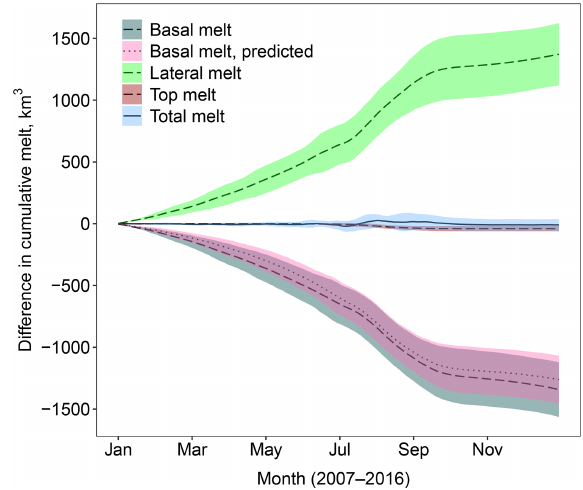
Figure 4. Difference in the cumulative lateral (green ribbon, dashed), basal (grey ribbon, dashed), top (red ribbon, dashed), and total (blue ribbon, solid) melts averaged over 2007–2016 between stan-fsd and ref. The ribbon shows, in each case, the region spanned by the mean value plus or minus 2 times the standard deviation for each simulation. A large increase is observed in the total lat- eral melt; however this is mostly compensated by a reduction in the basal melt, leading to a negligible change in total melt. A small re- duction in top melt can be seen. The predicted difference in basal melt is also shown on the plot (pink ribbon, dotted); this shows the expected change in basal melt accounting only for the reduction in sea ice concentration at grid cell scale from ref to